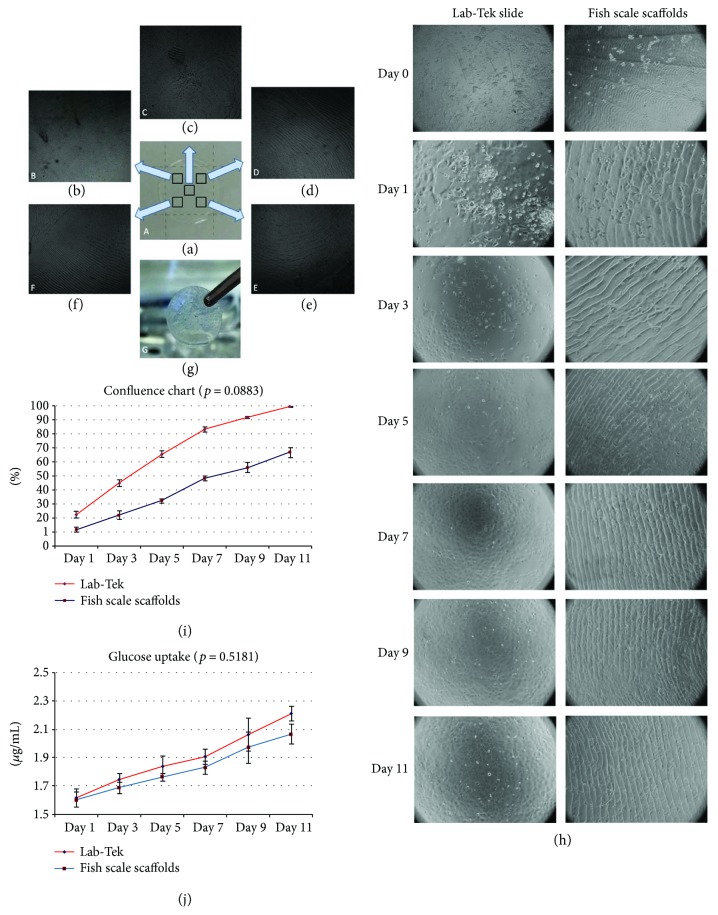
(a) FSS showed transparency, and when observed in bright field of the confocal microscope, (b) it showed narrow ridges and valleys. (c) Central FSS was rough but was relatively a flat surface compared to the other areas. (d and f) Second and third quadrants, respectively, showing broad ridges and valleys. (e) Fourth quadrant showing arc strokes. (g) Although the transparency of FSS after HCEnC culture was not objectively determined, the scaffold did not show any damage or high opacity when observed subjectively. (h) Differences in morphology between Lab-Tek and FSS grown HCEnCs at 40x magnification (for day 0, to appreciate the number of cells that were plated) and 100x magnifications on the rest of the days of culture. Most of the cells adhered and showed outgrowth on broad ridges (quadrants 2 and 3) and in the central FSS. (i) Growth rate of the cells in Lab-Tek was higher compared to that on FSS. 100% confluency was observed in Lab-Tek slides whereas around 65% confluency was observed in FSS at day 11 (p = 0.0883). (j) Glucose uptake was recorded in Lab-Tek-grown cells compared to fish scale scaffolds and showed active metabolism of cells without any significant difference between the two conditions (p = 0.5181). The data are expressed as the mean ± SD. FSS: fish scale scaffold; HCEnC: human corneal endothelial cell. Scale: (B–D) 100x magnification.